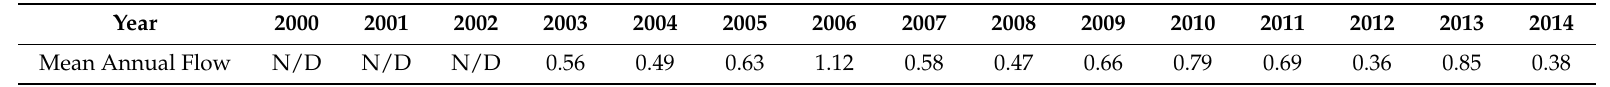
Table 3. Mean annual flow (m 3 · s − 1 ) in the Strzegomka River above the Dobromierz Reservoir— multi-annual data 2000–2014 (gauging station Chwalisz ó w